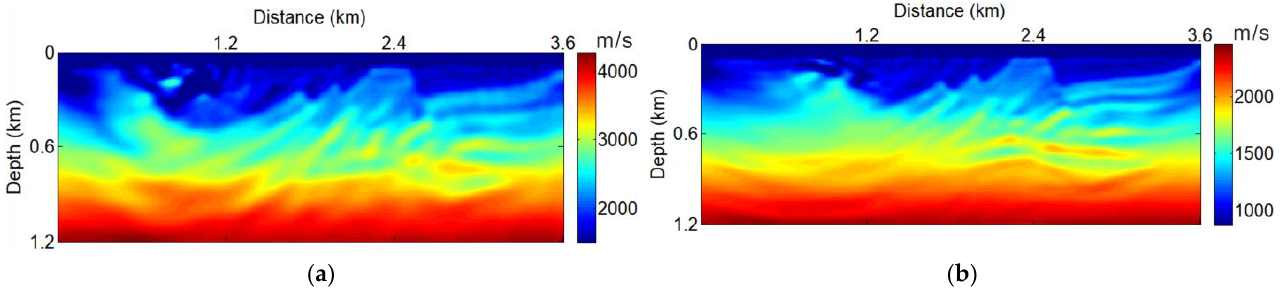
Figure 6. Conventional EFWI results with low-frequency data (5 – 10 Hz); ( a ) V p ; ( b ) V s .